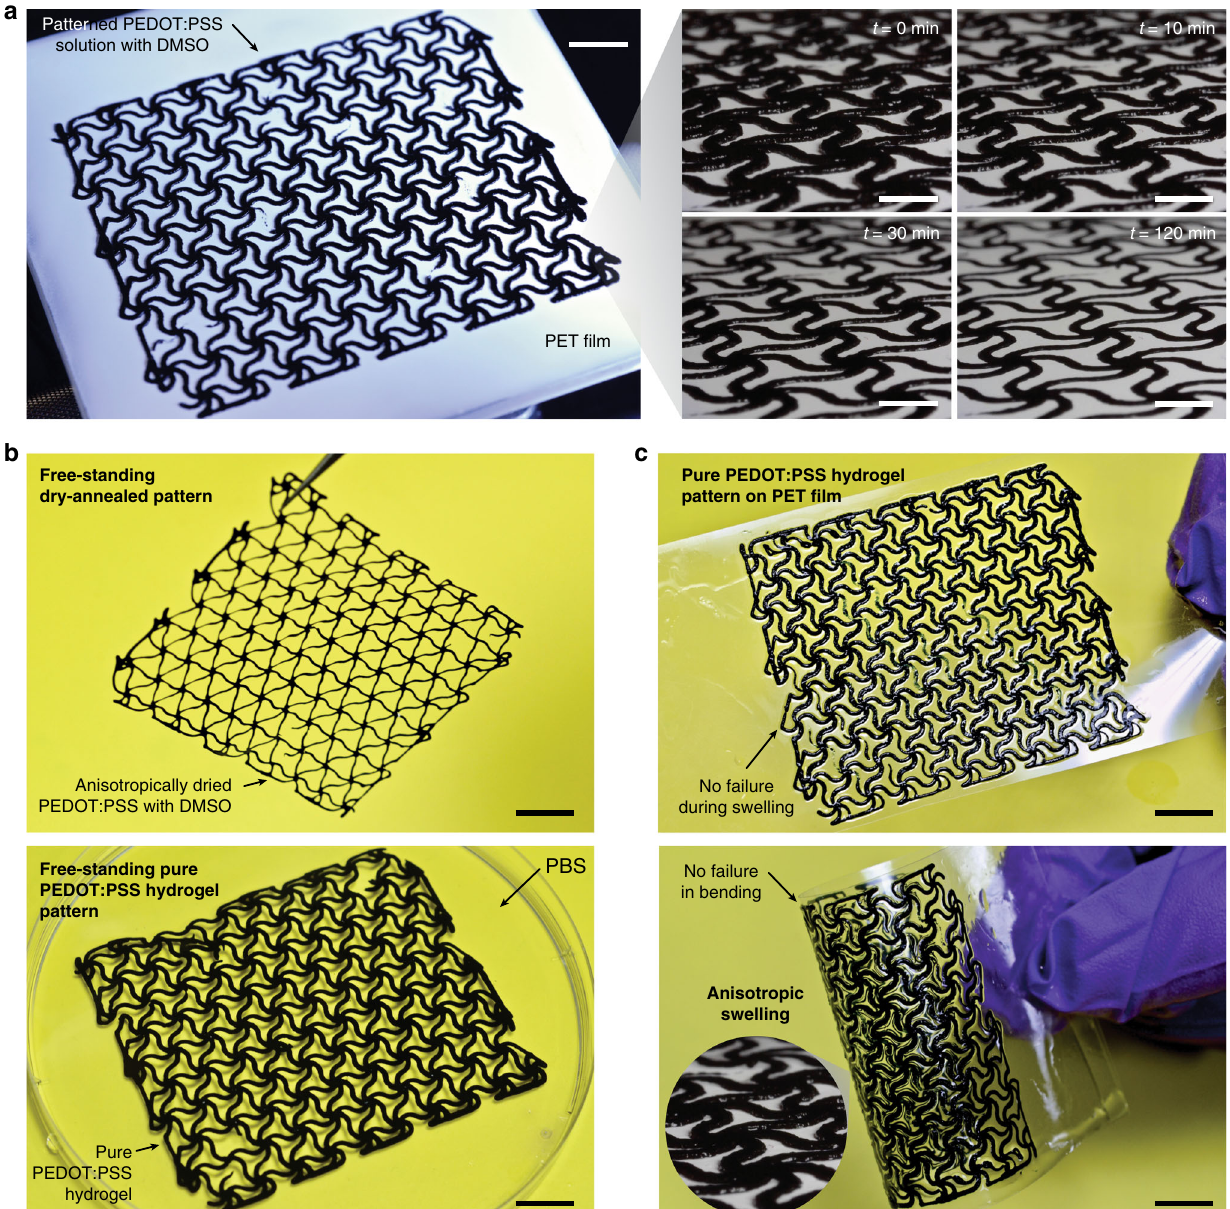
Fig. 5 Patterning of pure PEDOT:PSS hydrogels. a Patterned PEDOT:PSS solution on PET substrate. Experimental images show anisotropic drying process of the patterned ink over time. b Free-standing pure PEDOT:PSS hydrogel pattern can be fabricated by peeling the dry-annealed pattern and swelling in PBS. c Robust laminate of pure PEDOT:PSS hydrogel pattern can be fabricated by suppressing delamination via anisotropic swelling behavior. Scale bars, 10 mm ( a , left panel); 5 mm ( a , right panel); 8 mm ( b , c